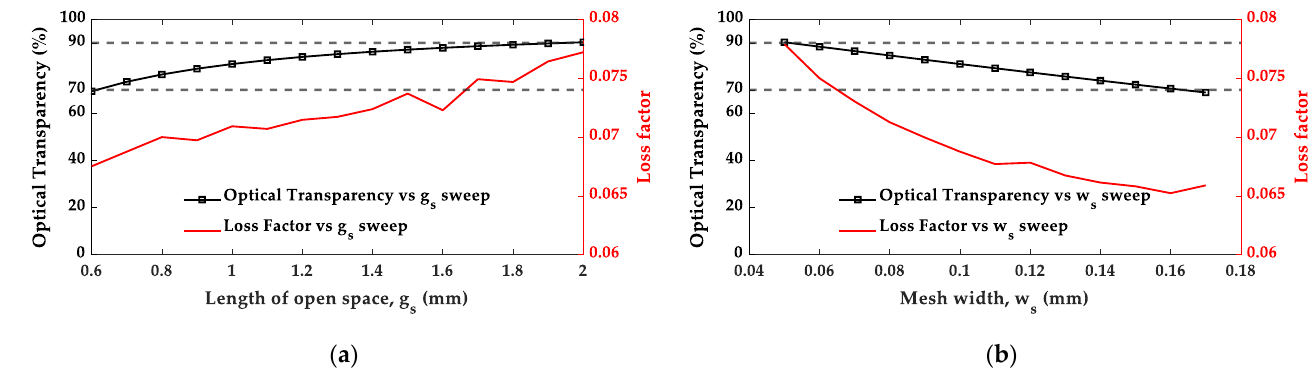
Figure 4. Effect of square mesh on loss factor: ( a ) length of the open space, 𝑔 𝑠 ; ( b ) mesh width, 𝑤 𝑠 .